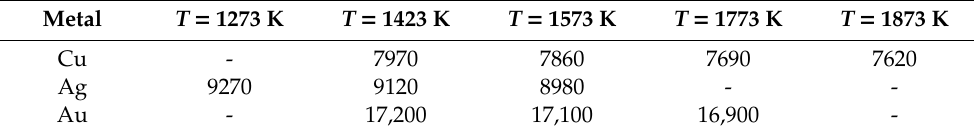
 (kg/m 3 ) used for calculations. Table 1. Input values of ρ (kg / m 3 ) used for calculations. Table 1. Input values of